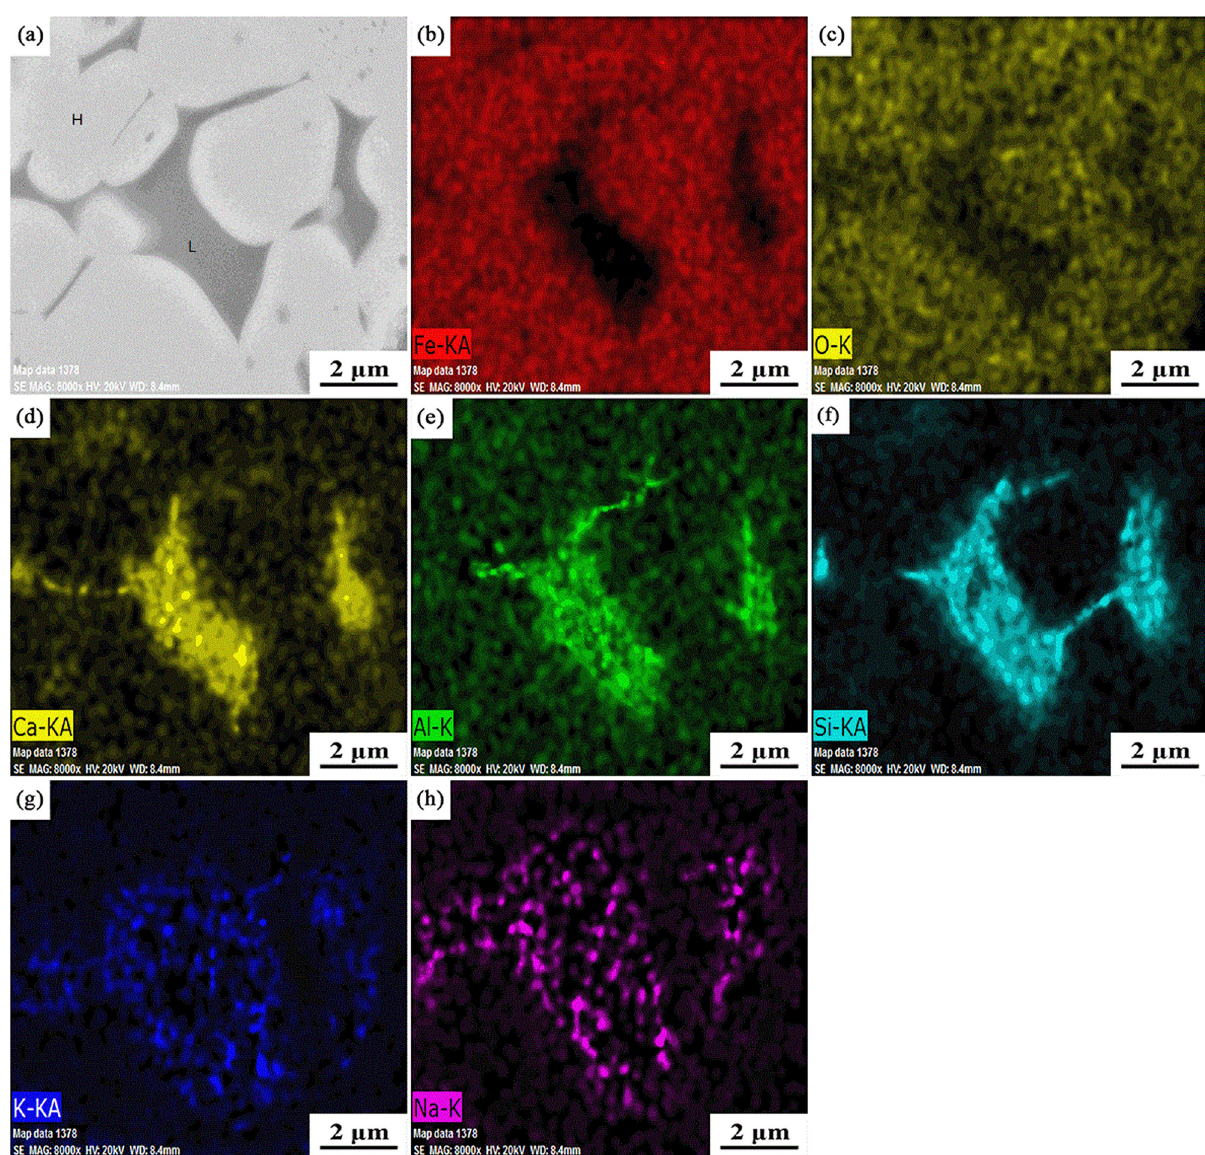
Figure 9: Typical SEM images and EDS maps of sample 2 # ( 0.6 wt% ( K 2 O + Na 2 O )) ( a ) H - Metal phase. L - Slag phase; ( b ) EDS maps of Fe; ( c ) EDS maps of O; ( d ) EDS maps of Ca; ( e ) EDS maps of Al; ( f ) EDS maps of Si; ( g ) EDS maps of K; ( h ) EDS maps of